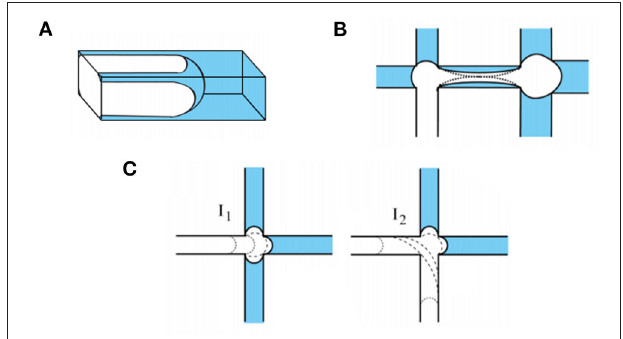
FIGURE 1 | Schematic representation of (A) piston-type displacement during drainage process in a rectangular tube, (B) snap-off in pore-throat during imbibition process, and (C) pore-body filling, I 1 and I 2 events, during imbibition process. CO 2 is shown in white and brine is shown in blue (Images from Rasmusson et al.,